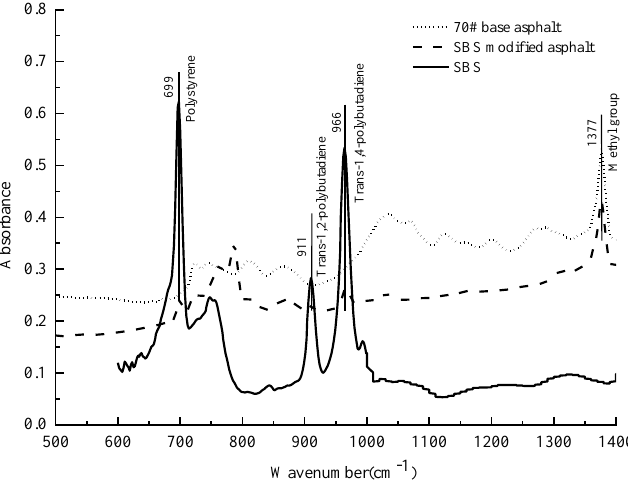
( b ) Figure 3. Calibration curves of SBS content based on ( a ) stiffness modulus S and ( b ) creep slope m. 3.2. FTIR Test Results 3.2.1. Analysis of FTIR Test Results The infrared spectrum of each sample is obtained by scanning it with an infrared spectrometer. Figure 4 shows the infrared spectrum of matrix asphalt, SBS, rubber oil and SBS-modified asphalt in the wave number region between 500 – 1400 cm −1 . Comparing the infrared spectrum of matrix asphalt and SBS modifier, it can be found that the methyl and methylene groups in matrix asphalt produce a characteristic absorption peak near 1377 cm −1 , which is not affected by SBS modifier because SBS does not have this peak. The in- frared spectrum of SBS has two strong absorption peaks, one is formed by the out-of-plane